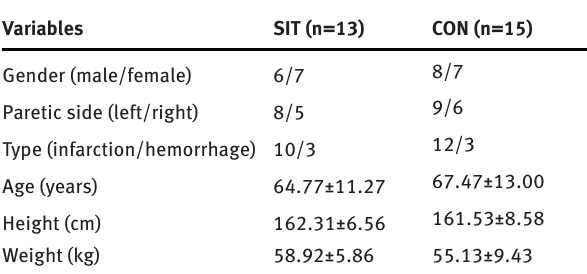
Table 1: General characteristics of the subjects (number